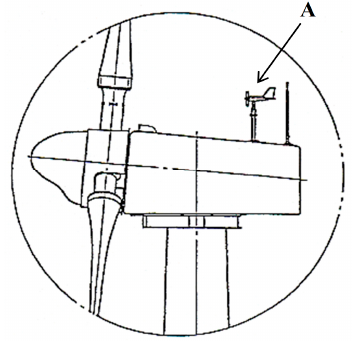
Figure 3. Propeller vane anemometer mounted on a WT nacelle (indicated by “A”).